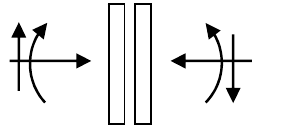
Figure 3. The single resistant masonry cell.